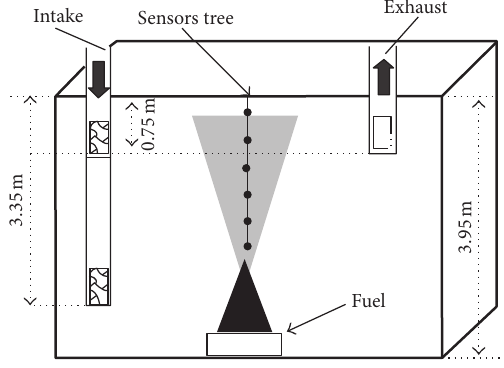
Figure 3: Configuration of validation